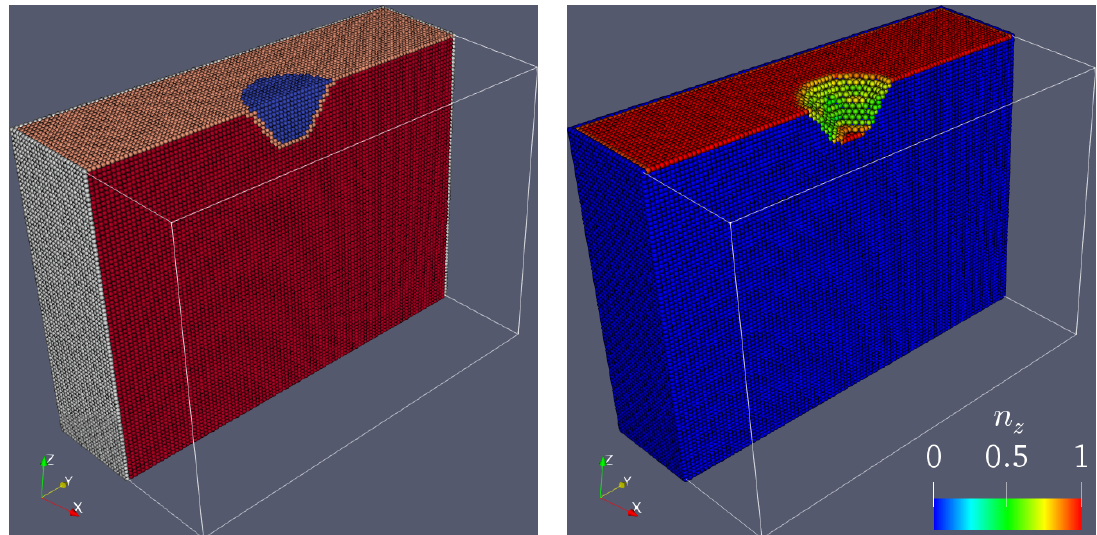
Figure 2. Illustration of how the proposed boundary treatment works. Left: the particle label is color coded, where red shows the active particles, white the wall boundaries, orange the laser surface, and blue the molten particles. Boundary conditions are applied to white and orange particles, while blue molten particles are effectively deleted from the simulation. Right: the color indicates the z -component of the unit normal vector pointing outward from the laser-irradiated surface, i.e., n z computed from Equation (22). The laser heat source expressed in Equation (2) is multiplied by n z for those particles exposed to the